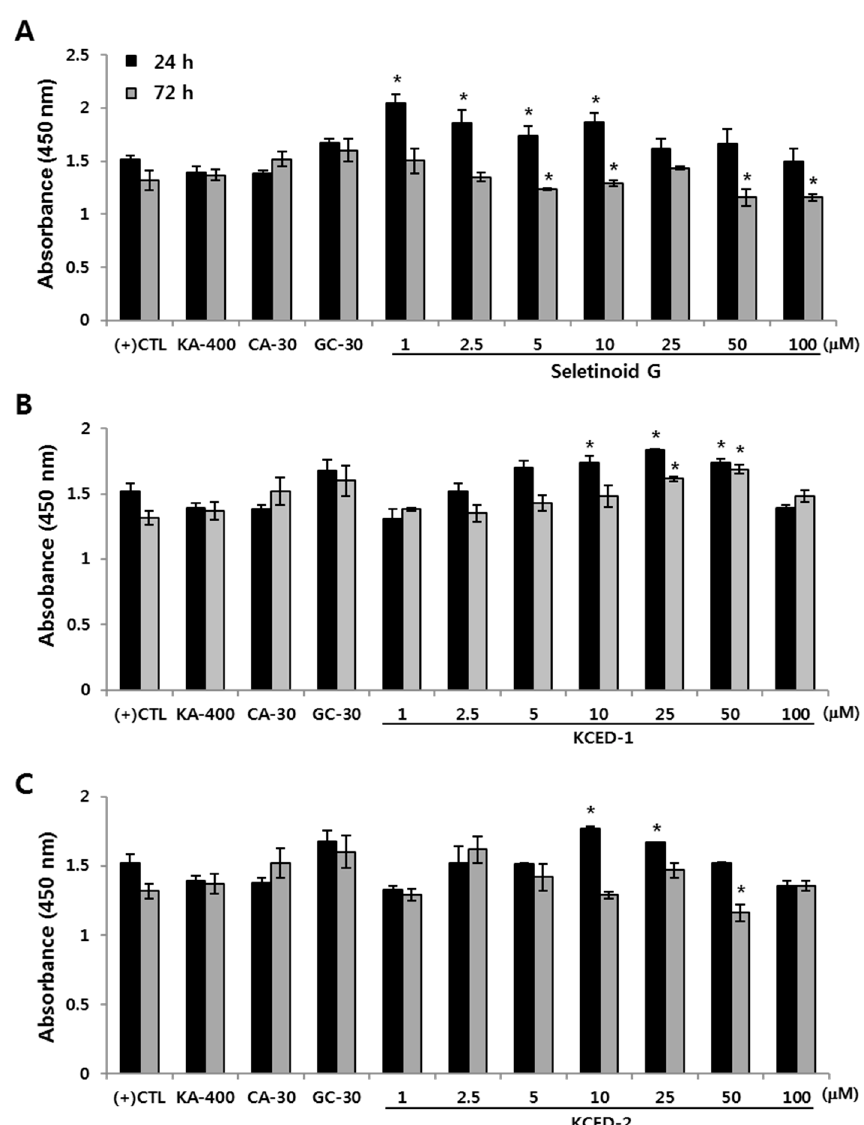
Figure 2. The effect of SG, KCED-1, and KCED-2 on cell viability of human subcutaneous fat cells (hSCFs). The hSCFs were treated with ( A ) SG, ( B ) KCED-1, and ( C ) KCED-2 for 24 or 72 h, after which the cell viability was analyzed. The data are presented as the mean ± SD (* p < 0.05). KA-400, kojic acid-400 µ M; CA-30, cinnamic acid-30 µ M; GC-30, glibenclamide-30 µ M; CTL, control.